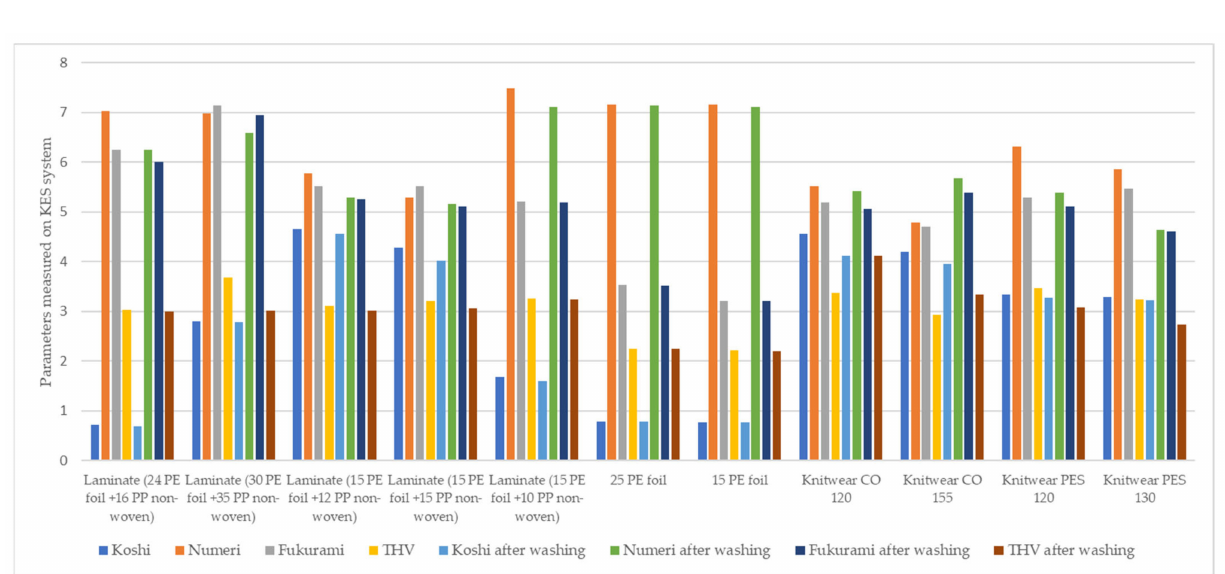
Figure 13. The parameters measured on KES